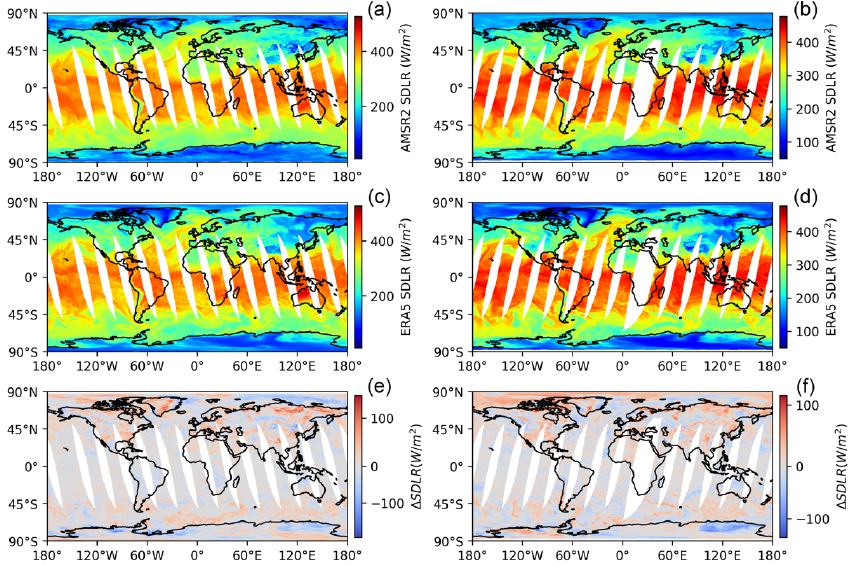
Figure 7. Comparison of the global Advanced Microwave Scanning Radiometer 2 (AMSR2) and European Centre for Medium-Range Weather Forecasts (ECMWF) Reanalysis v5 (ERA5) surface downward longwave radiation (SDLR) data from 1 January 2020. ( a ) AMSR2 SDLR derived from ascending data; ( b ) AMSR2 SDLR derived from descending data; ( c ) ERA5 SDLR matched with ascending data; ( d ) ERA5 SDLR matched with descending data; ( e ) difference between AMSR2 and ERA5 SDLR for ascending data; and ( f ) difference between AMSR2 and ERA5 SDLR for descending data.